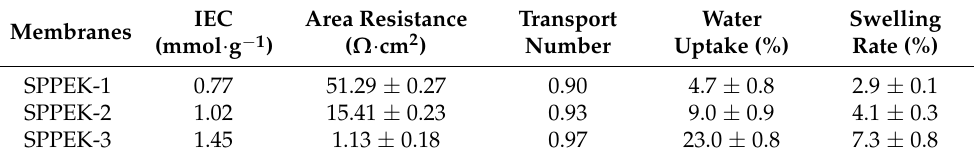
Table 3. The electrochemical properties and dimensional stability of prepared membranes and commercial CMX.